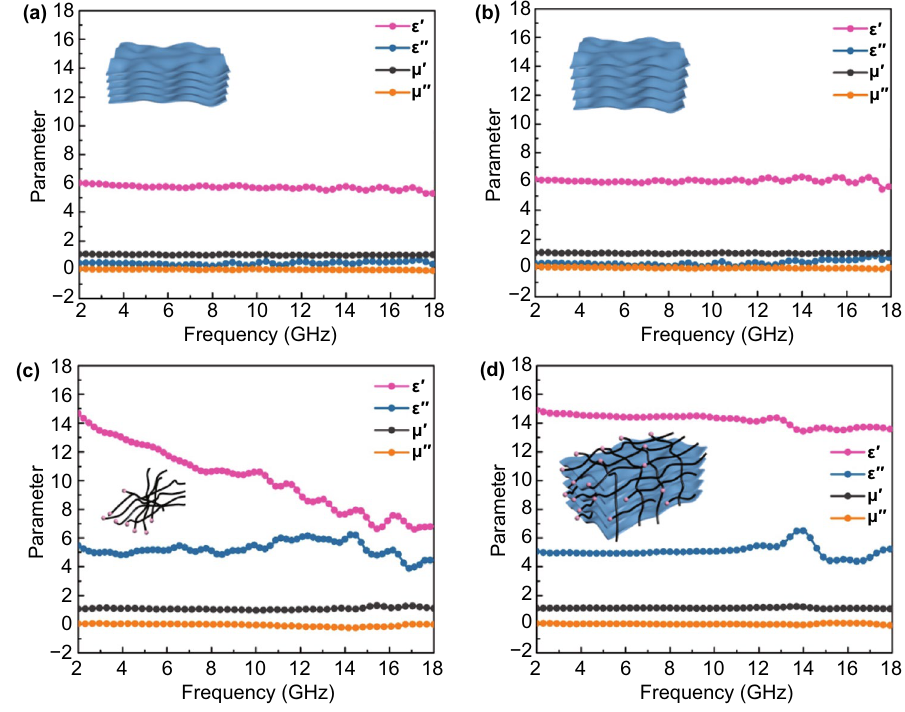
Fig. 4 Permittivity and permeability versus frequency of a MXene, b MXene-N, c CNTs/Ni and d MXene-CNTs/Ni